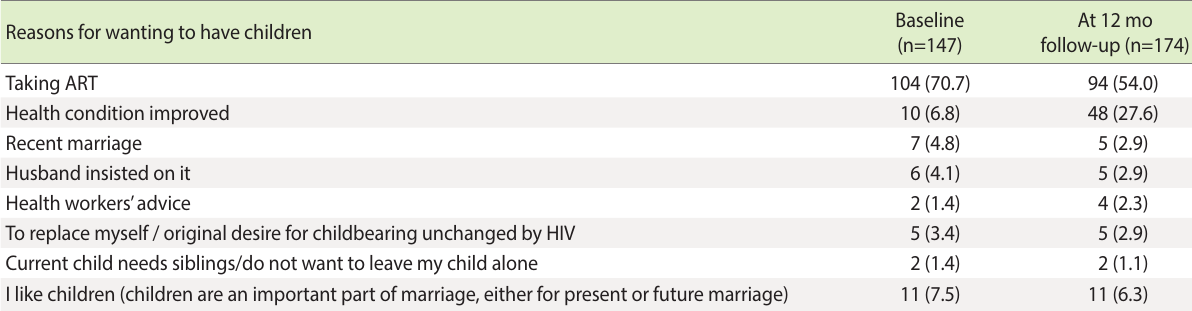
Table 4. Reasons for wanting to have children in the future (before and after) Reasons for wanting to have